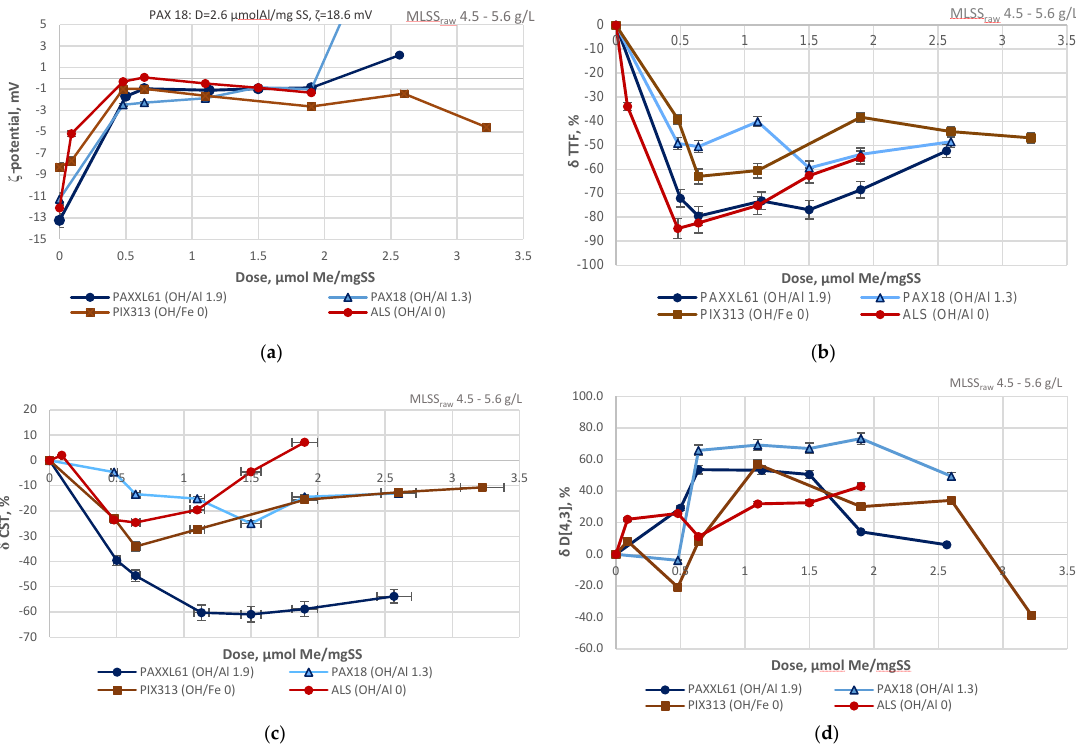
Figure 8. Influence of the coagulant dose on the monitored parameters at fixed pH during the total recycle test (TRT): ( a ) zeta potential; ( b ) TRT change; ( c ) CST change; ( d ) volume moment mean change. The filtration time, required for reaching 1.2 × TMP in and the average normalized